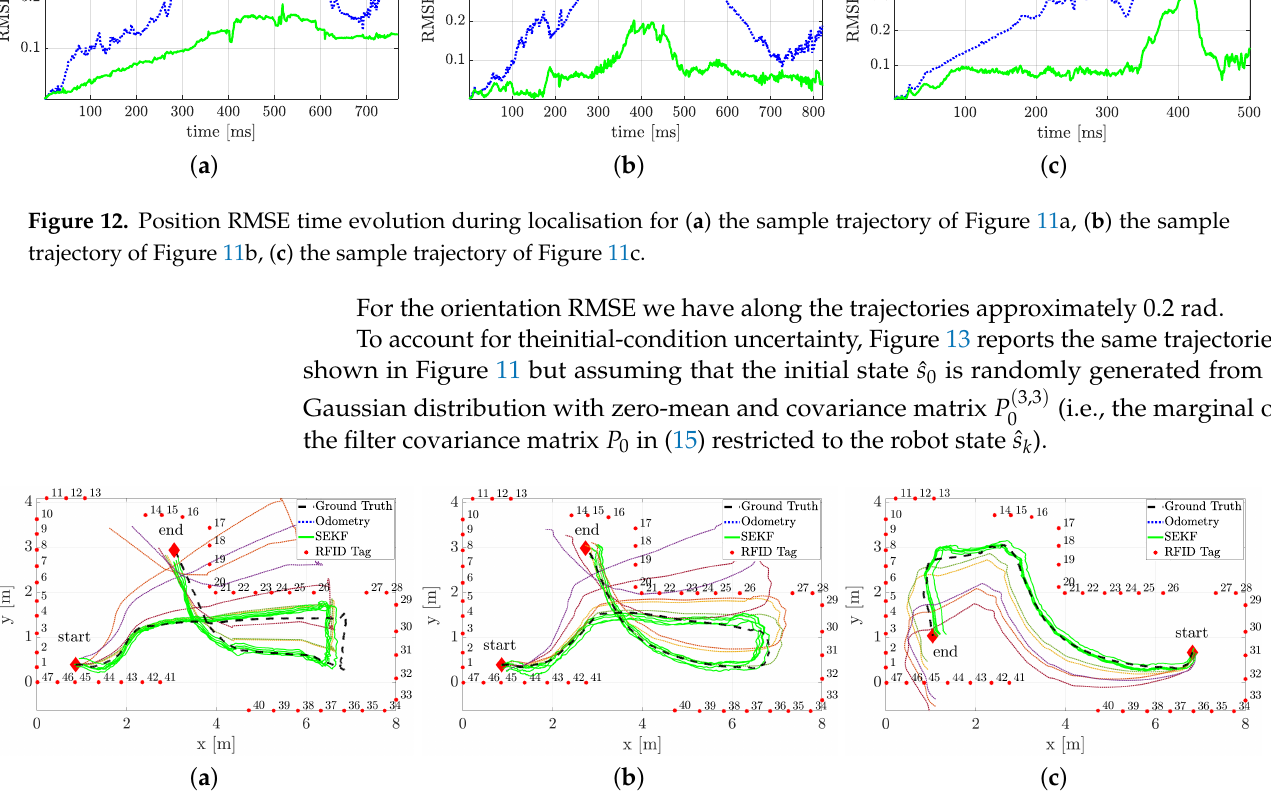
Figure 13. Trajectory estimation for ( a ) the sample trajectory of Figure 11a, ( b ) the sample trajectory of Figure 11b, ( c ) the sample trajectory of Figure 11c with different range of uncertainties about the true initial